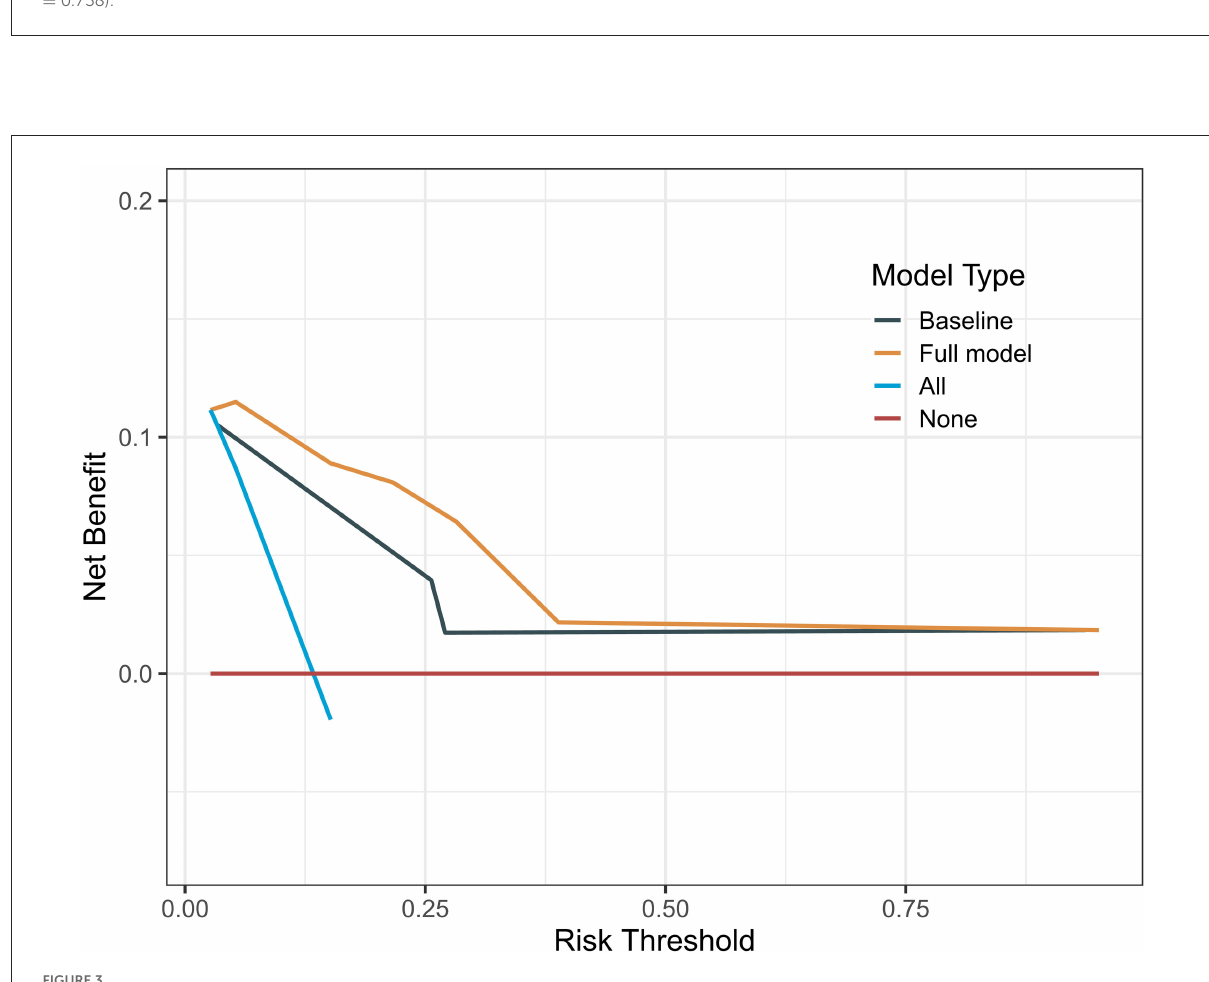
FIGURE3 Decision curves of the prognostic models showed that the prognosis model based on risk scores and baseline data was more